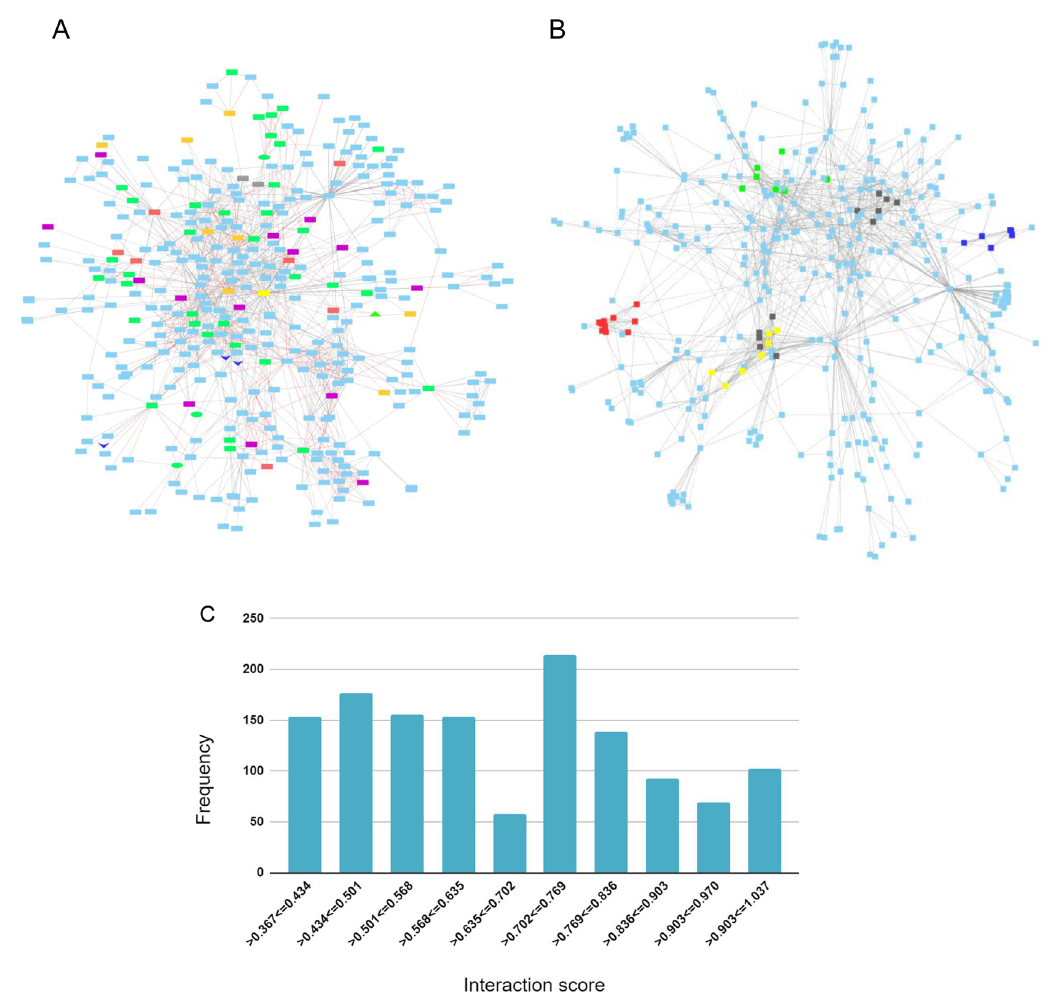
Figure 4. APP protein-protein interaction network. ( A ) Geneset overlap between 1 st and 2 nd shell interactions and the AD-DS, Chr 21, DEX DFC, and DEX CBC genesets. AD-DS genes unique: red; Chr 21 genes unique: gray; DEX DFC genes unique: purple; CBC genes unique: orange; AD risk factors (RF) and AD-DS genes shared: green; DEX DFC genes shared with RF & AD-DS genes: green oval; CBC and DFC shared genes: dark blue V; CBC genes shared with RF: green triangle; APP: yellow rectangle. ( B ) Interaction network gene clusters. Cluster 1: red – COP subunits, signalosome complex, development; Ubiquitin, Cluster 2: yellow – Tubulin, microtubules, motors, intracellular transport; Cluster 3: green – apoptosis, insulin signaling, ubiquitin, VEGFR growth factor signaling; Cluster 4: blue – Ubiquitin, autophagy; and Cluster 5: black – APP processing (PSEN, gamma secretase complex). ( C ) Distribution frequency for interaction